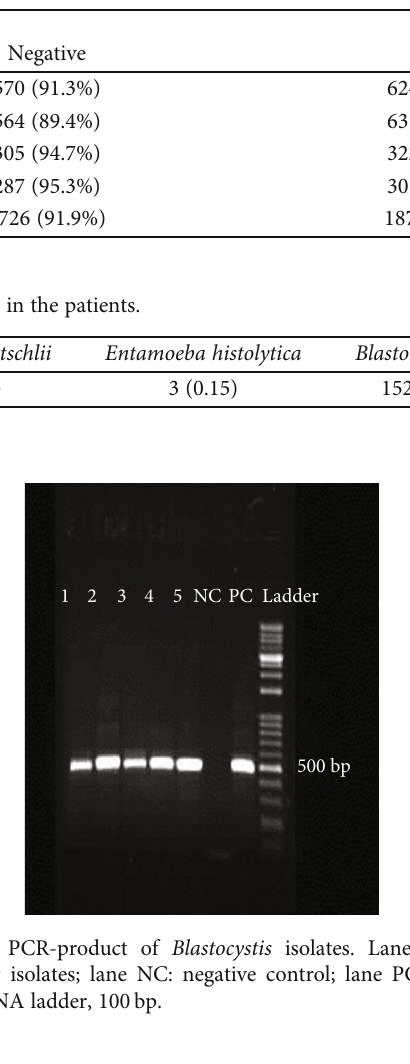
Table 4: The rate of Blastocystis spp. infection in di ff erent season.